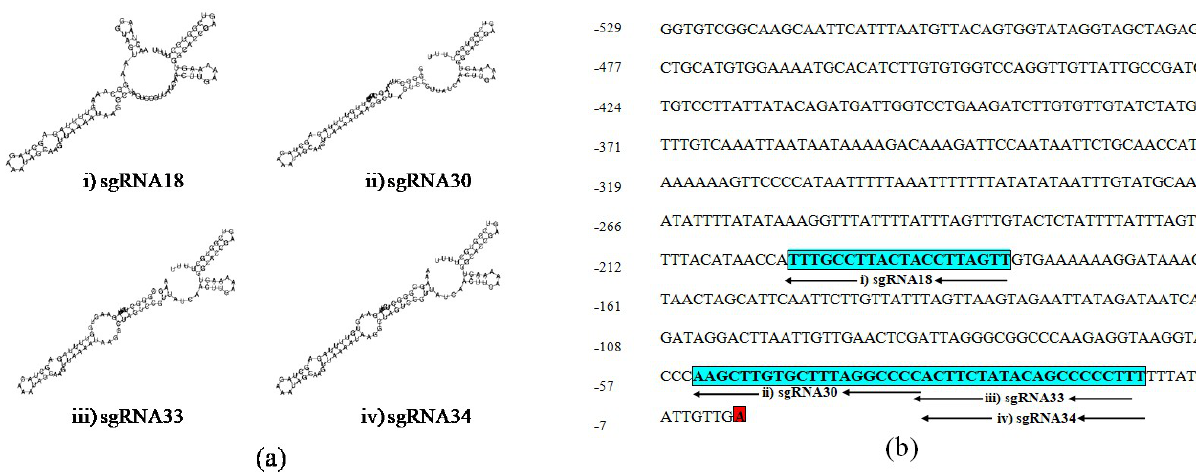
Figure 2. Schematic secondary structure of the selected sgRNAs and their position on the proximal promoter region of UGT76G1 : ( a ) The secondary structure of sgRNAs: (i) sgRNA18, (ii) sgRNA30, (iii) sgRNA33, and (iv) sgRNA34, and ( b ) Blue boxes show the sequence and positions of four selected sgRNA:; (i) sgRNA18, (ii) sgRNA30, (iii) sgRNA33, and (iv) sgRNA34, and red box shows transcription start site (TSS).